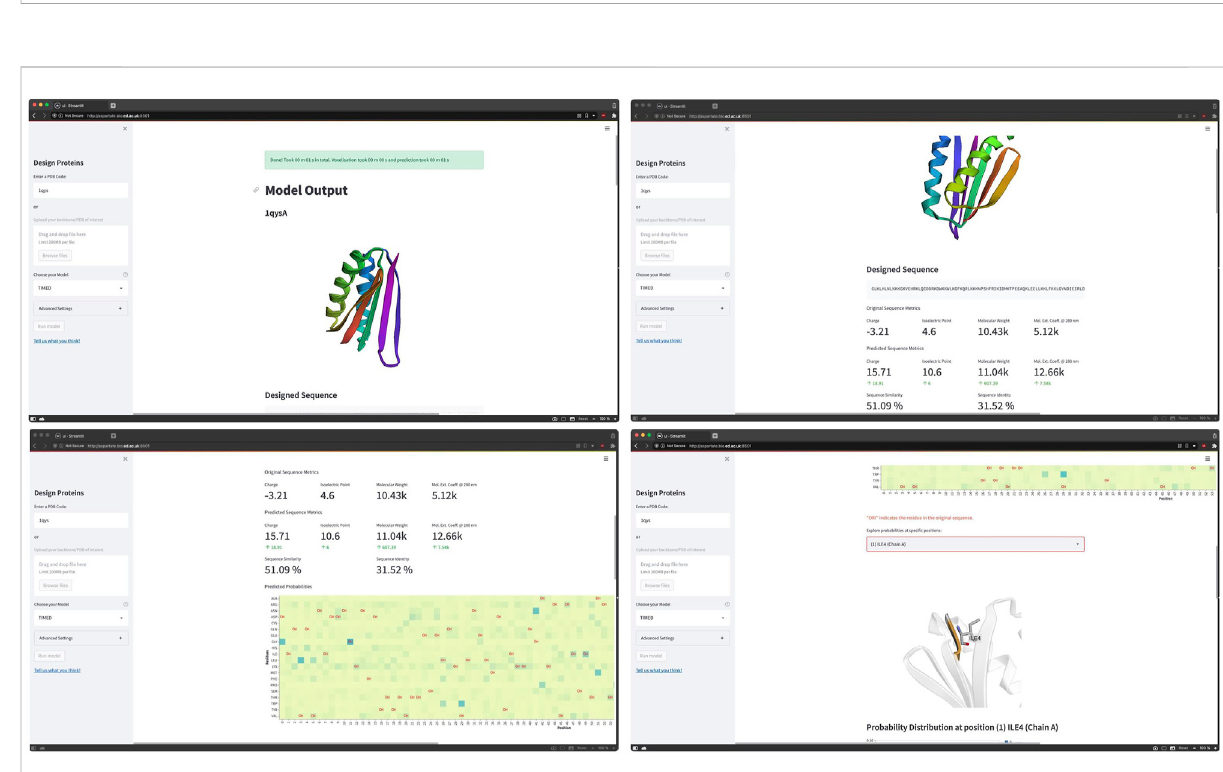
FIGURE 9 Screen-captures of TIMED web app. Images courtesy of Leonardo V. Castorina who is one of the contributors of the TIMED project. TIMED tackle the “ Inverse Folding Problem ” aiming to identify the residue sequence that will reliably fold into a given structure.